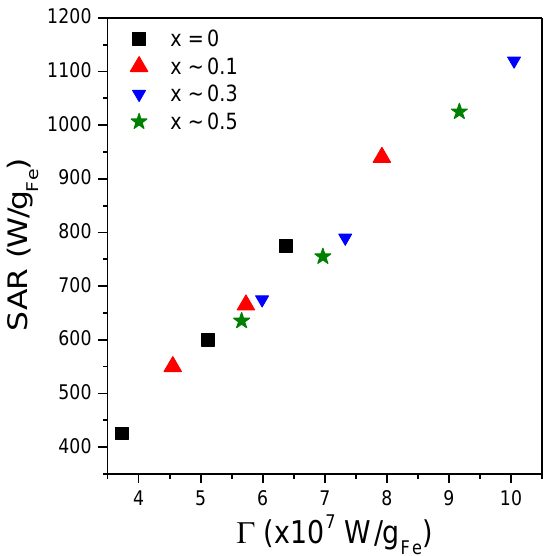
Figure 9. Saturation SAR values as a function of the coe ffi cient Γ values resulted from fitting the SAR = f ( H ) curves by Equation (8), for all four types of MNPs in the three di ff erent